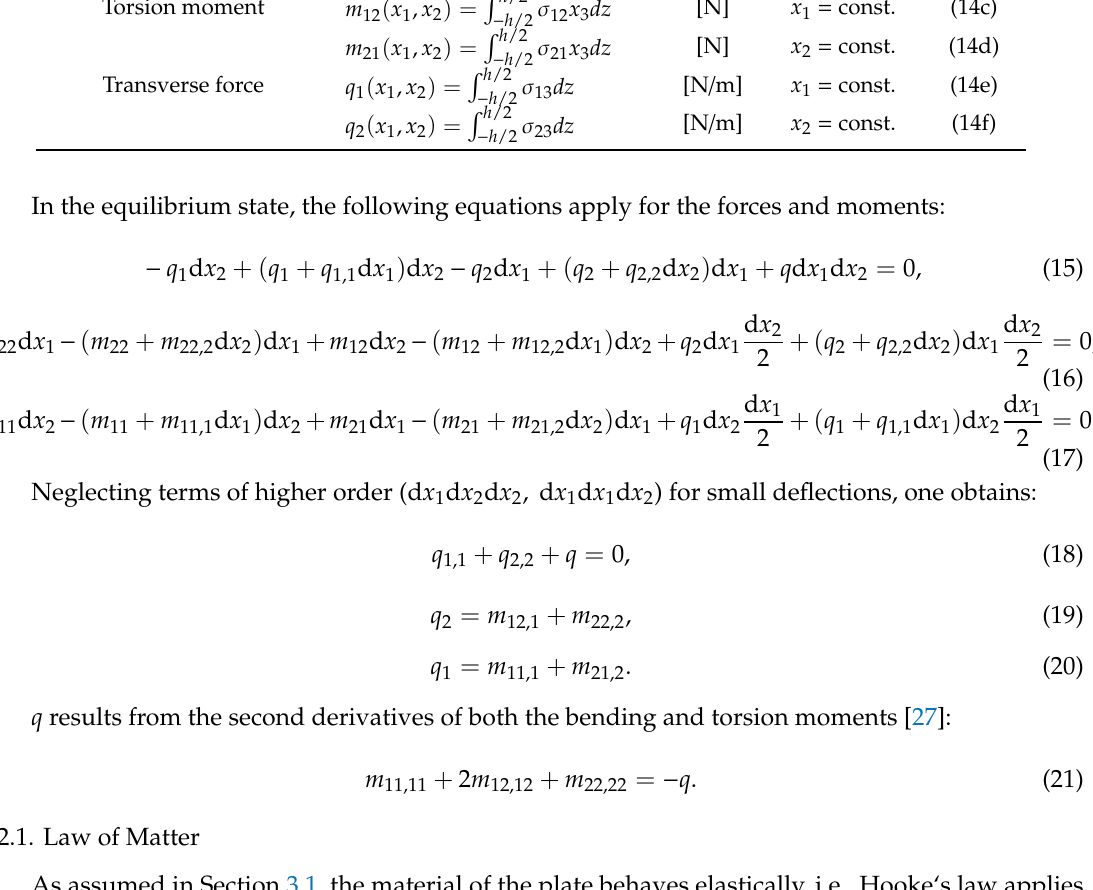
Figure 4. Moments and forces acting at a plate part with d A = d x 1 d x 2 (adapted from Reference [27]).